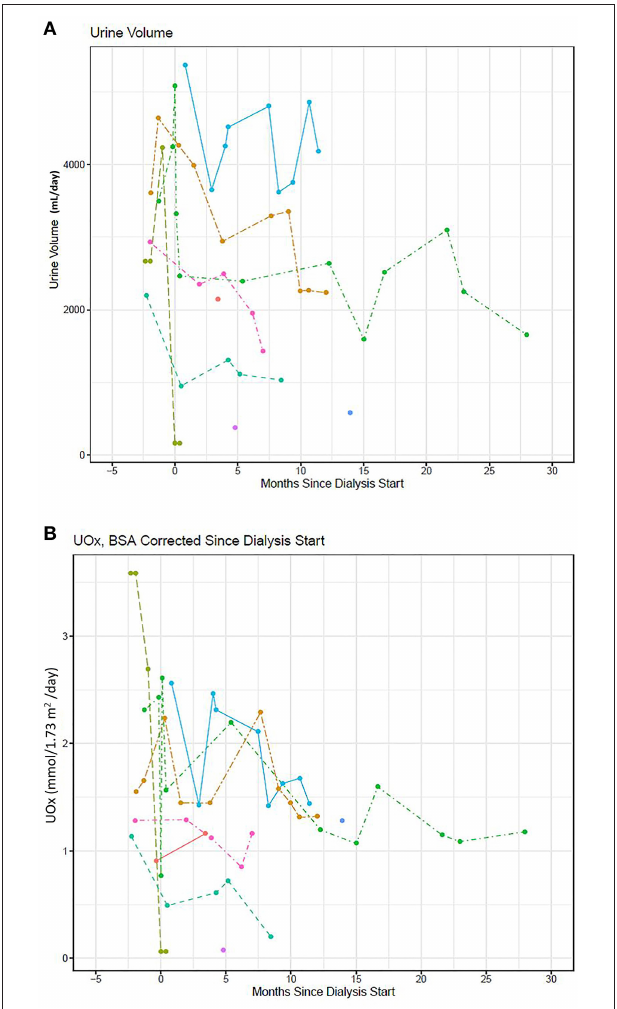
FIGURE 3 | (A) Urine output (mL/day) and (B) urine oxalate excretion/BSA (mmol/1.73m 2 /day) over time since initiating RRT ( n =